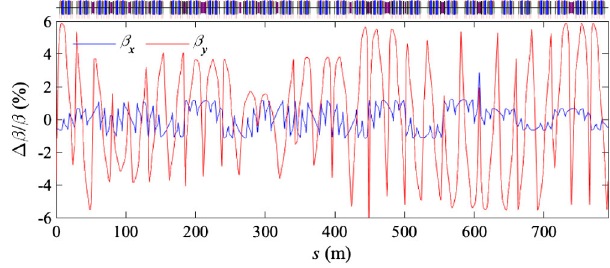
FIG. 2. Distortion of β functions caused by the undulators.